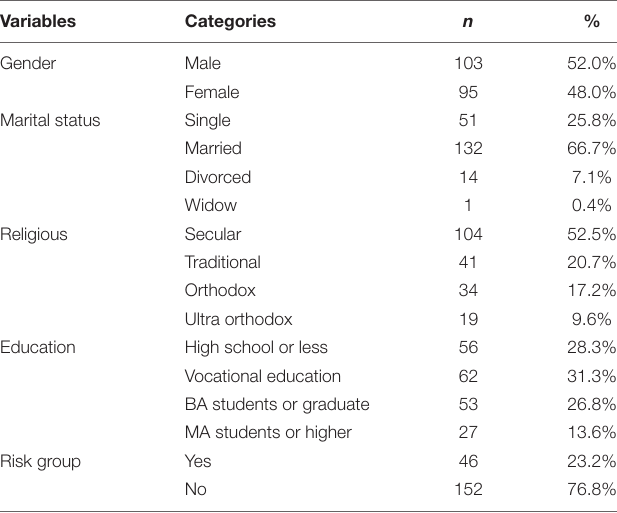
TABLE 1 | Description of the gender, marital status, religious, education, and risk group